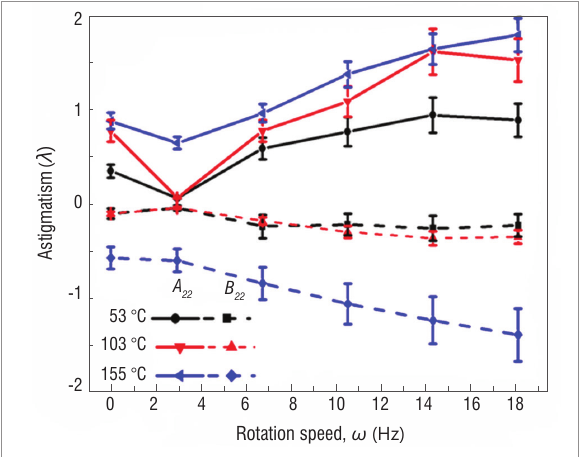
Figure 7: x - and y -Astigmatism in the boundary layer of the spinning pipe gas lens at selected wall temperatures.